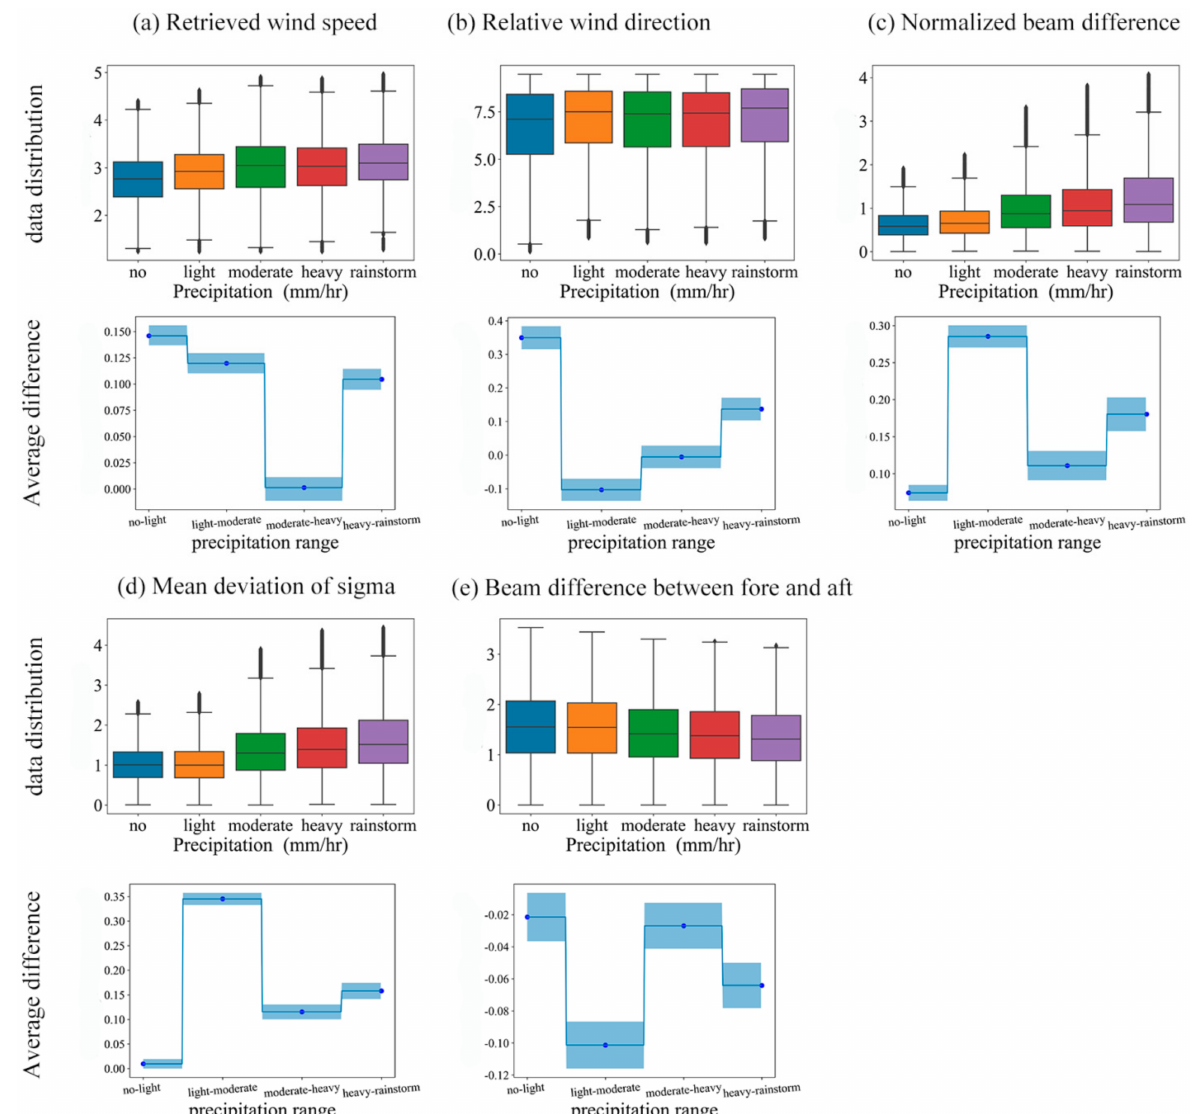
Figure 5. Response of sensitive parameters to precipitation changes. The rain-sensitive parameters are as follows: ( a ) retrieved wind speed; ( b ) relative wind direction; ( c ) normalized beam difference; ( d ) mean deviation of NRCS; ( e ) beam difference between fore and